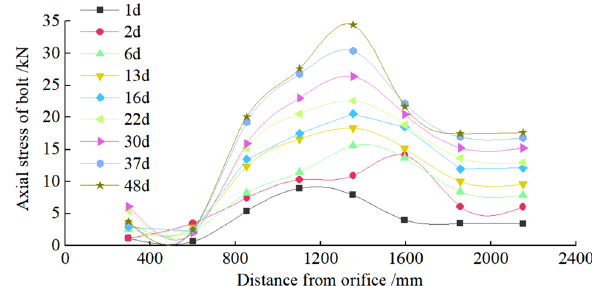
Figure 34. Axial Force of Anchor Bolt.